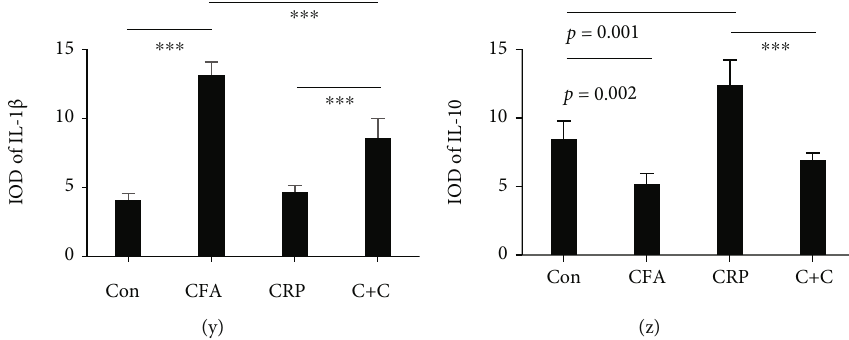
Figure 6: In fl ammatory cytokine expression based on RT-qPCR and IHC results. The mRNA expression levels of (a) CRP, (b) TNF- α , (c) IL-1 β , (d) IL-2, (e) IL-6, and (f) IL-10. ( N = 8 ; mean + SD ; ∗∗∗ p < 0 : 001 ). (g) – (j) The IHC results of CRP expression in the synovial membrane from Con, CFA, CRP, and C + C groups, respectively. (k) – (n) The IHC results of TNF- α from Con, CFA, CRP, and C + C groups, respectively. (o) – (r) The IHC results of IL-1 β from Con, CFA, CRP, and C + C groups, respectively. (s) – (v) The IHC results of IL-10 from Con, CFA, CRP, and C + C groups, respectively. (w) – (z) Semiquantitative analysis of (g) – (v). ( N = 6 ; mean + SD ; ∗∗∗ p < 0 : 001 e ff ects in CIA by dampening in fl ammatory responses [27].